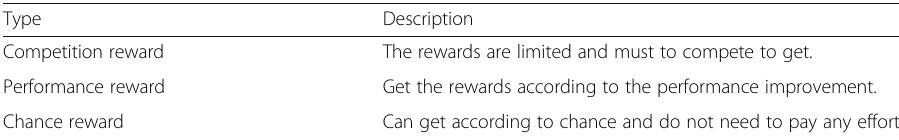
Table 1 Reward types Type Description Competition